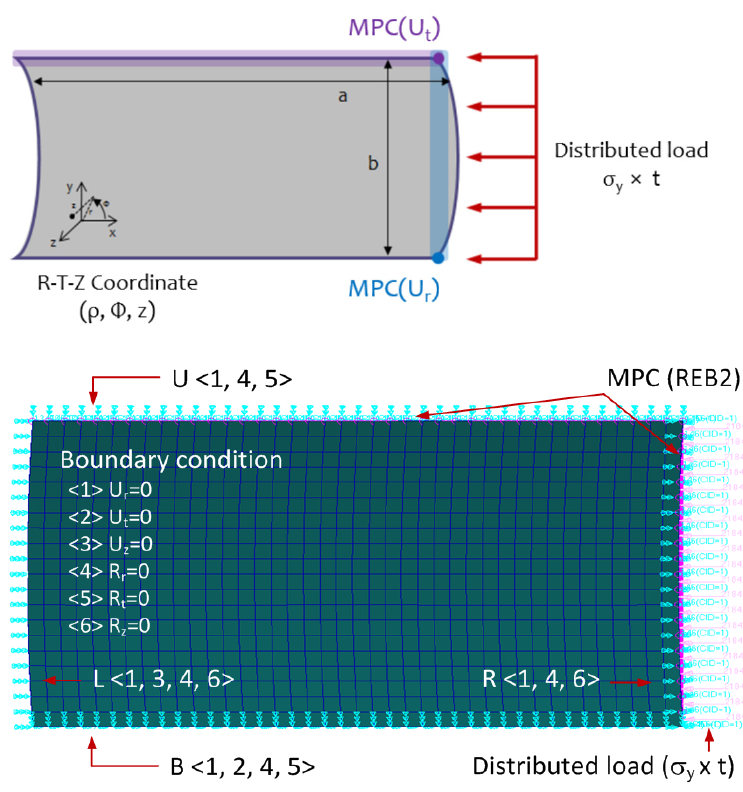
Figure 10. Loading and boundary conditions of the curved plate.